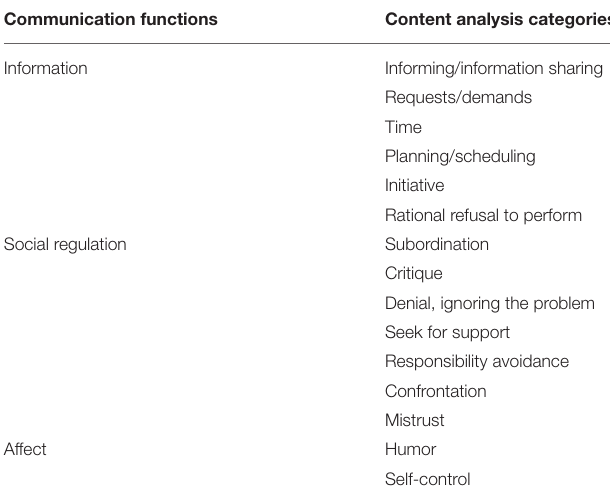
TABLE 2 | The main categories of content analysis and communication functions, as per Lomov (1981). Communication